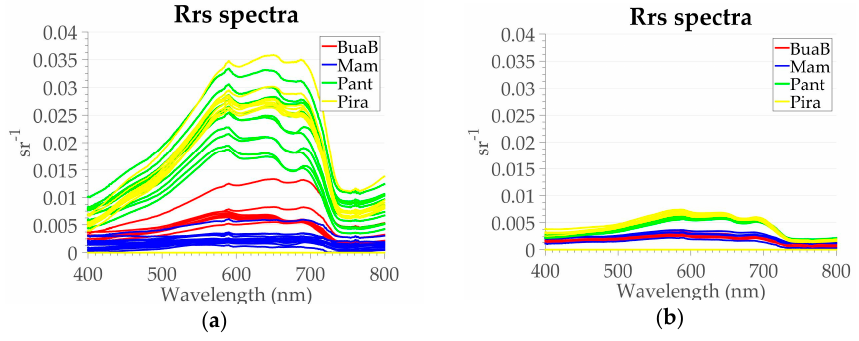
Figure 2. Rrs spectra for each lake in different water phases. ( a ) Mission 2 and 3 (rising water period); ( b ) Mission 1, 4, and 5 (receding water period). Each lake is represented by a specific color; Mamirauá in Blue, Bua-Buá in red, Pantaleão in green, and Pirarara in yellow.